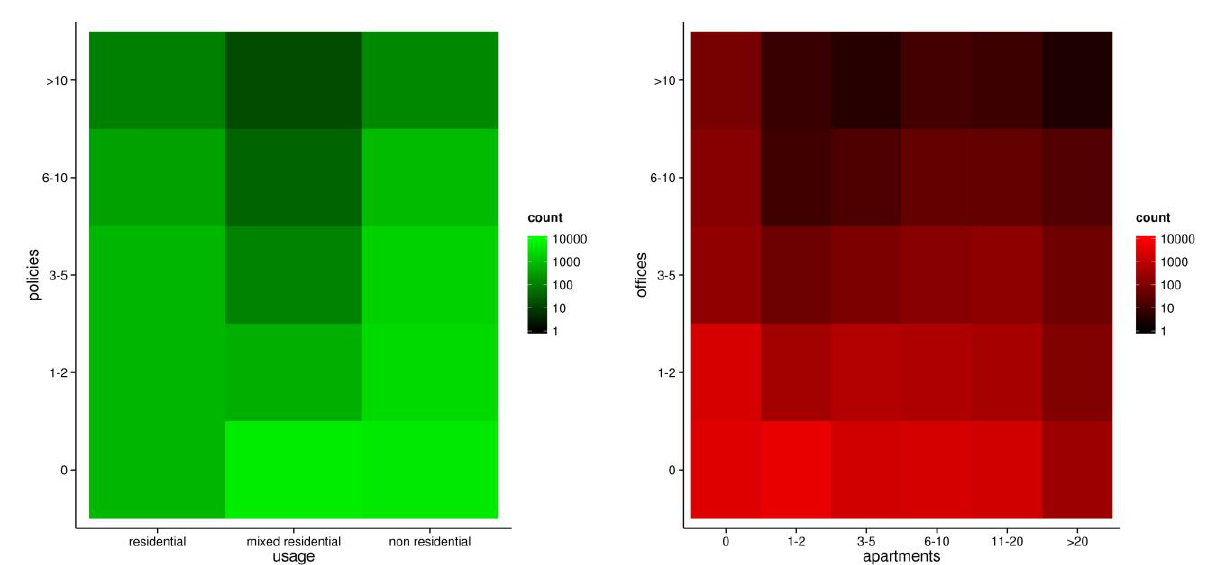
Figure 1. Overview of the study area Besiktas, Istanbul, Turkey ( left ); zooming in (yellow rectangle in the left map) on the distribution of buildings and related earthquake insurance policies in the Besiktas district ( right ).